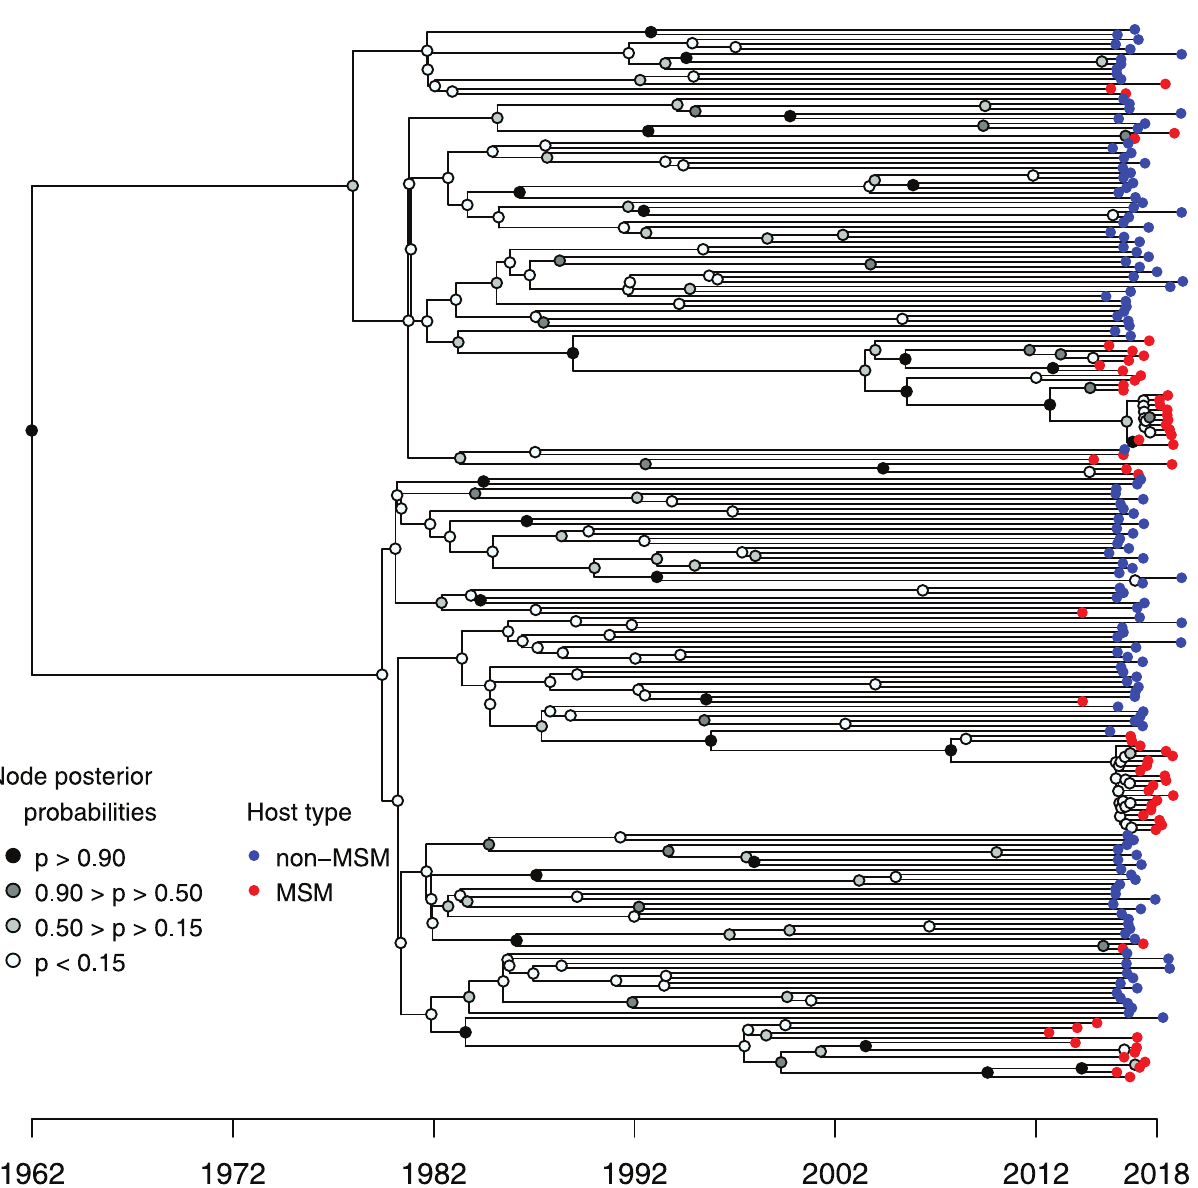
Fig 1. Phylogeny of HCV infections in the area of Lyon (France). Non-MSM hosts are in blue and MSM hosts are in red. Sampling events correspond to the end of black branches. The phylogeny was estimated using Bayesian inference (Beast2). The gray level of a node indicates its posterior probability. See the Material and methods for additional